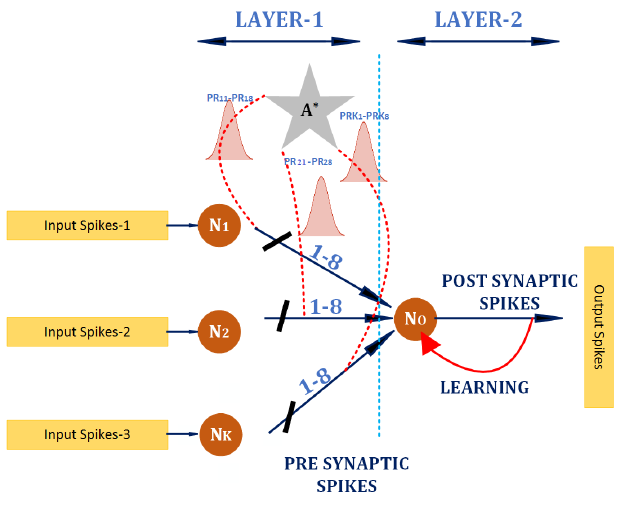
Figure 2. Parameter verification using spiking neural